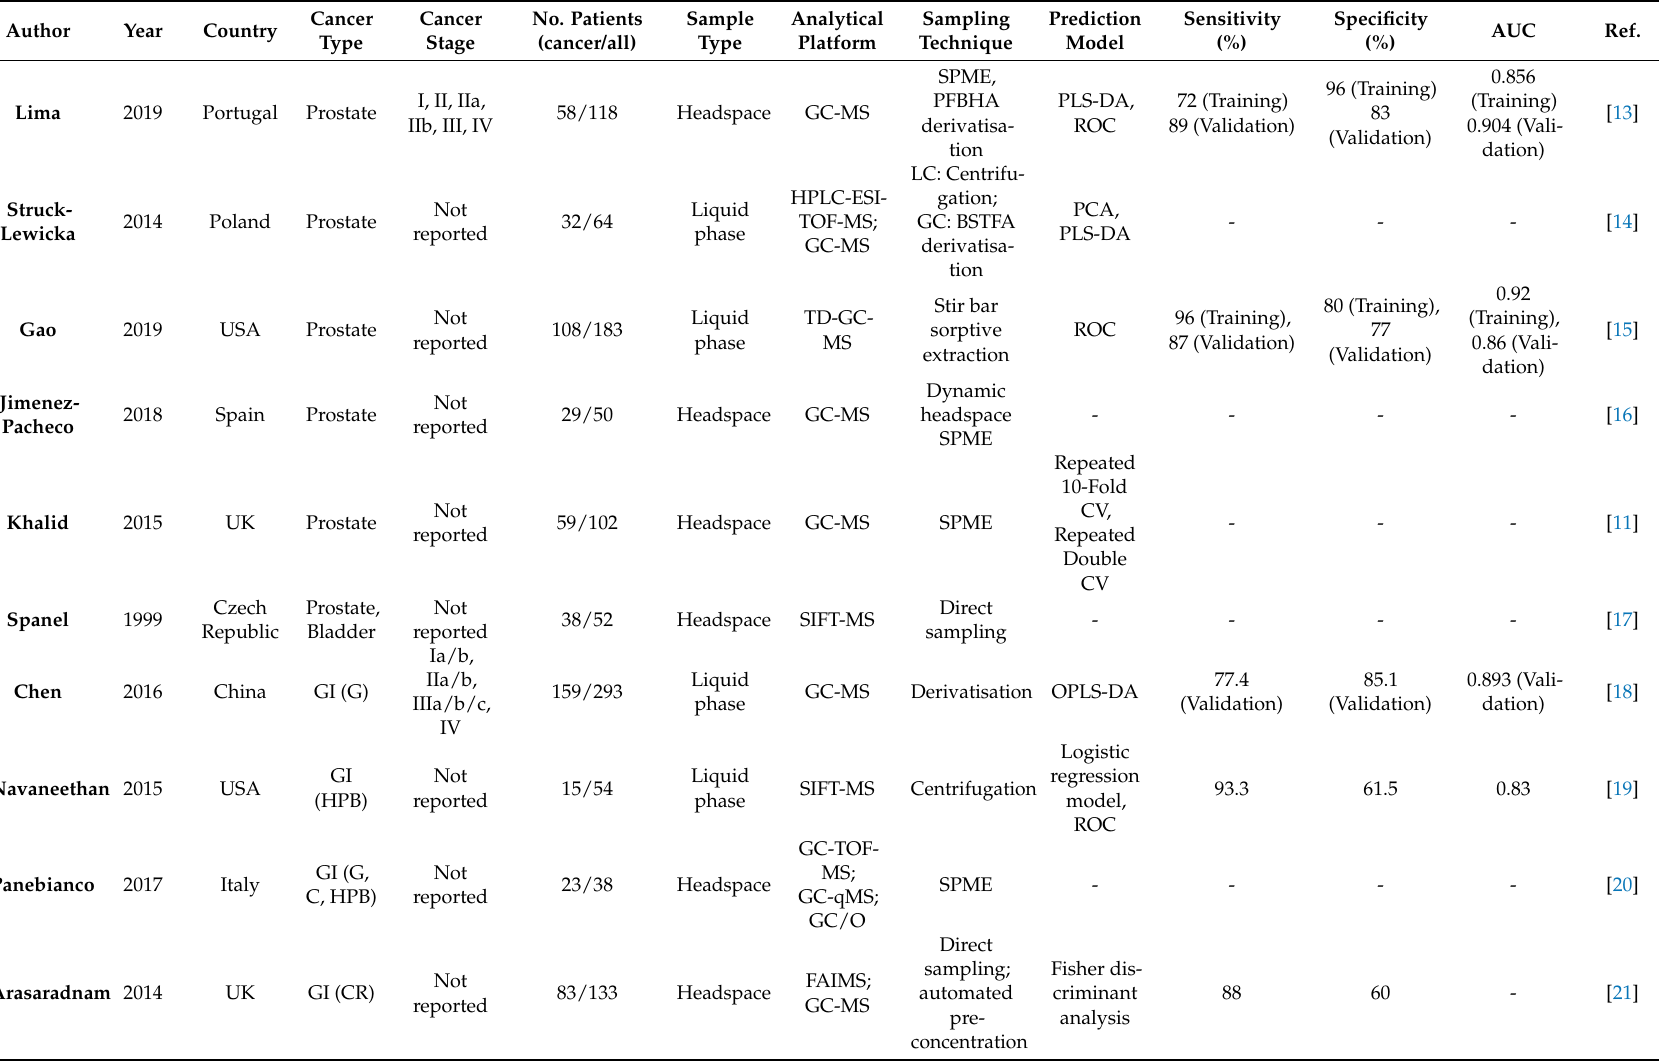
Table 1. Study characteristics. Urinary volatile organic compound analysis for cancer diagnosis: analytical and biostatistical techniques for biomarker